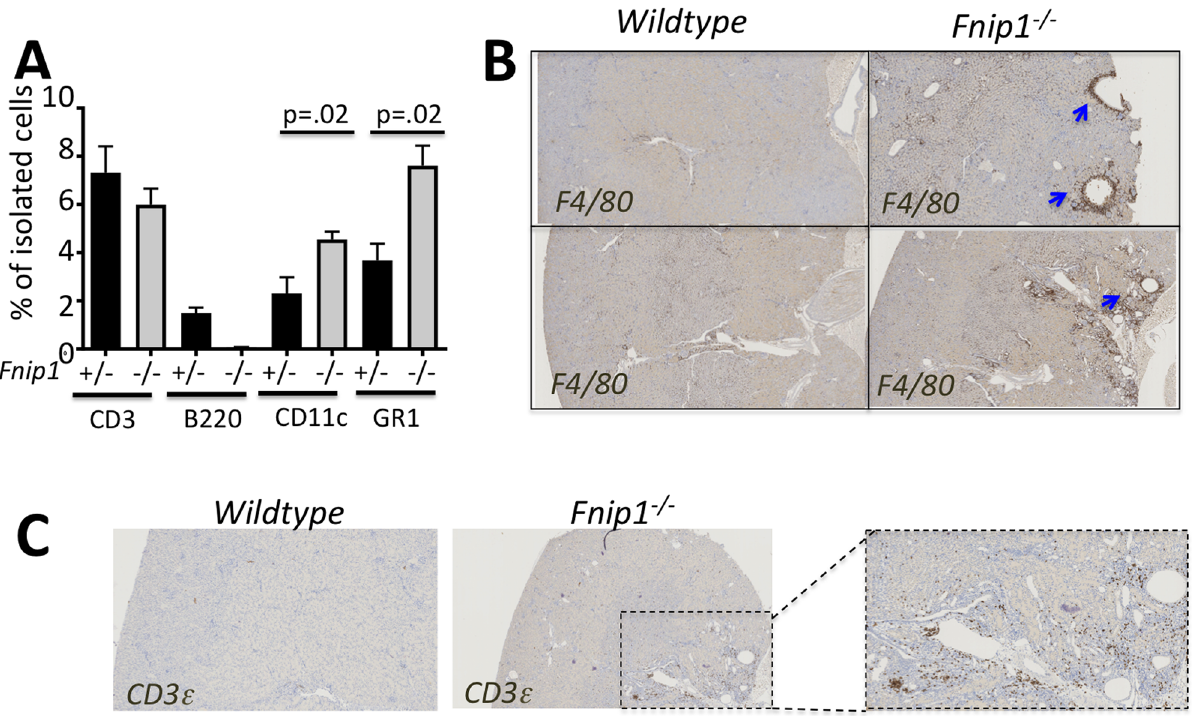
Fig 6. Increased immune cell infiltration in Fnip1 -/- null kidney tissue. (A) Flow cytometric analyses of immune cells isolated from Fnip1 -/- and wildtype kidney tissue showing increases in the representation of CD11c and GR1 labeled cells and decreases in B220 labeled cells (n = 3 of each genotype, p-values are shown). (B) Representative immunohistochemistry images showing increased representation of F4/80 + myeloid cells and (C) increased representation of CD3 + cells localized around renal cysts of Fnip1 -/- mice (arrows). Micrographs are representative of 3 mice per group (~12 weeks of